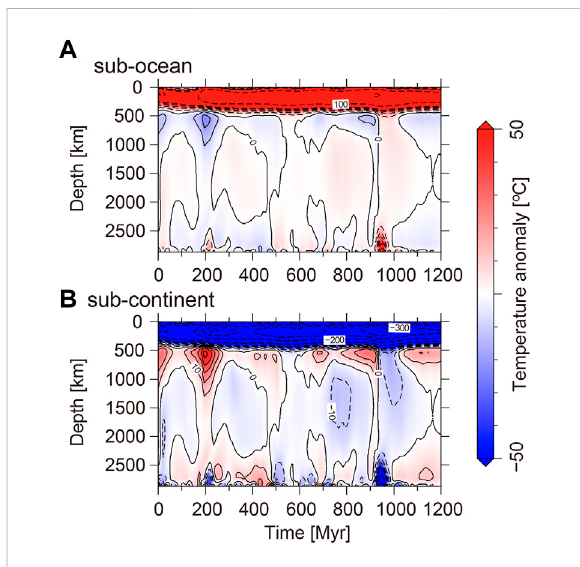
FIGURE 8 Time sequence of the depth pro fi le of δ T ( d ) at each elapsed time in (A) sub-oceanic region and (B) sub-continental region, where δ T ( d ) is the lateral average of the integrated temperature anomaly over the entire surface at each depth ( d ). For the mathematical de fi nition of δ T ( d ), see Eq. 4 in Yoshida (2013). The elapsed times correspond to those in Figure 7. The intervals of the solid line contour are 10 ° C for δ T ( d ) ≥ 0 ° C, and the intervals of the dashedlinecontourare10 ° Cfor − 50 ° C ≤ δ T ( d ) ≤ 0 ° C,and100 ° Cfor δ T ( d ) ≤ − 100 °